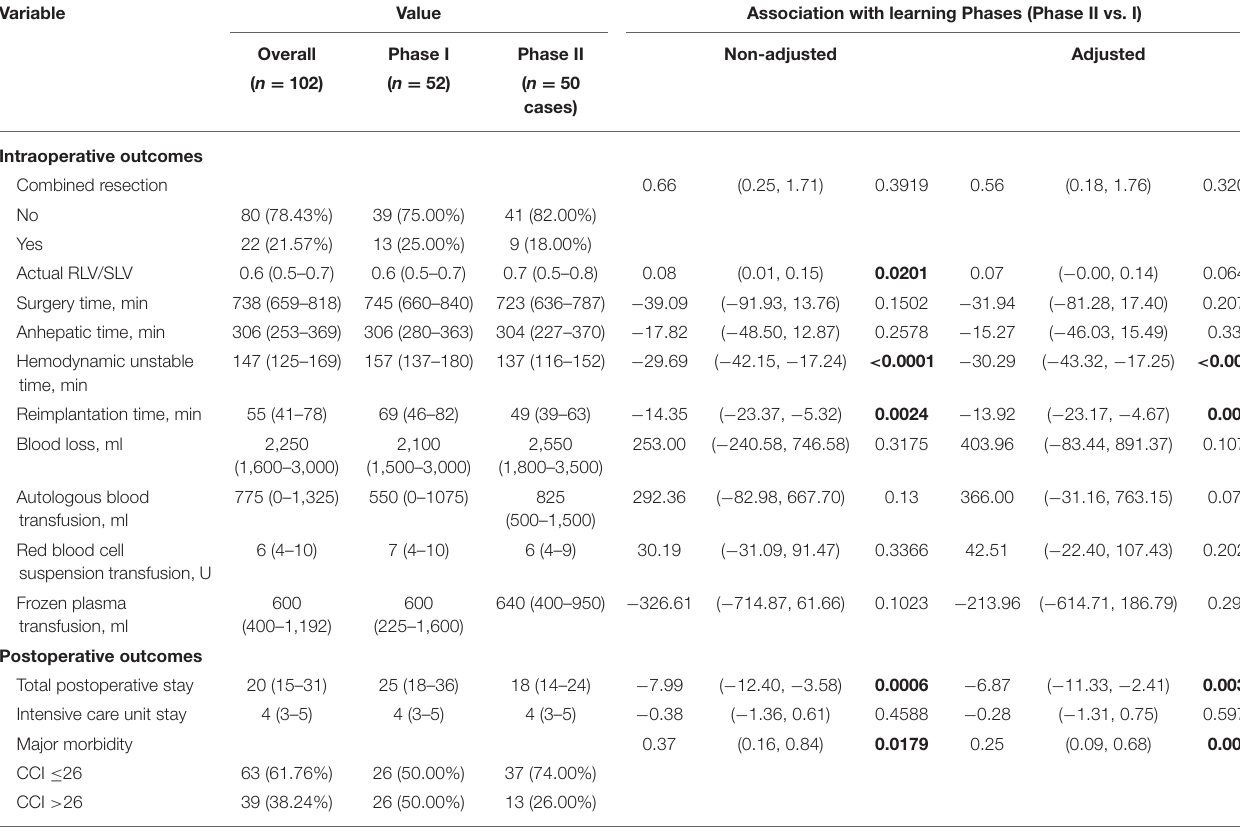
TABLE 2 | Association of learning phases with intraoperative and postoperative outcomes.